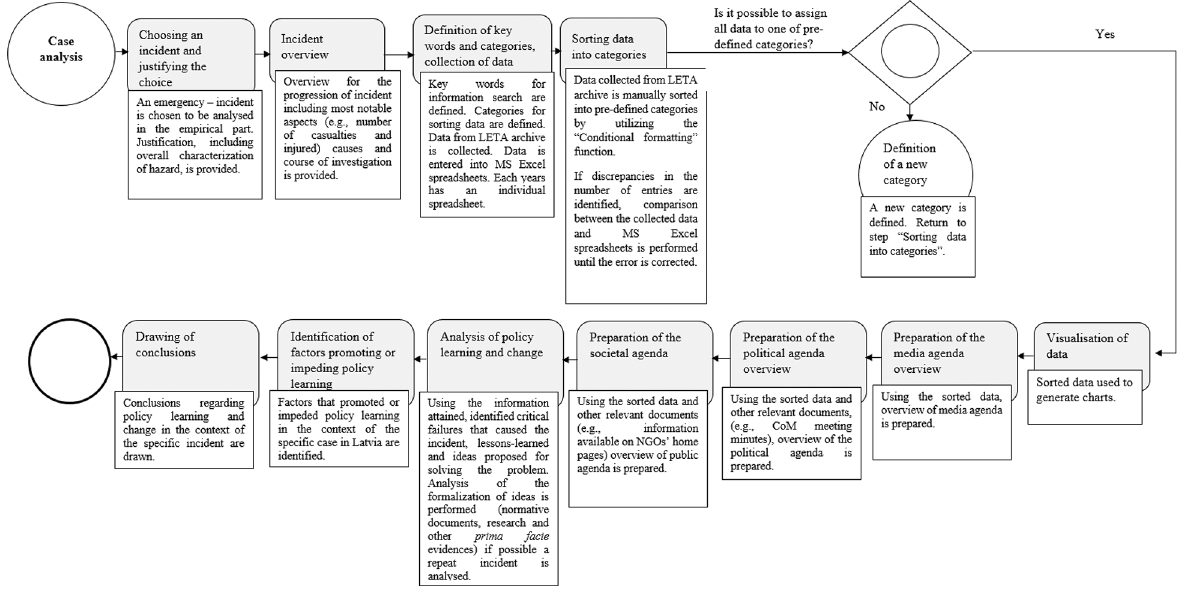
Figure 2. Empirical analysis process